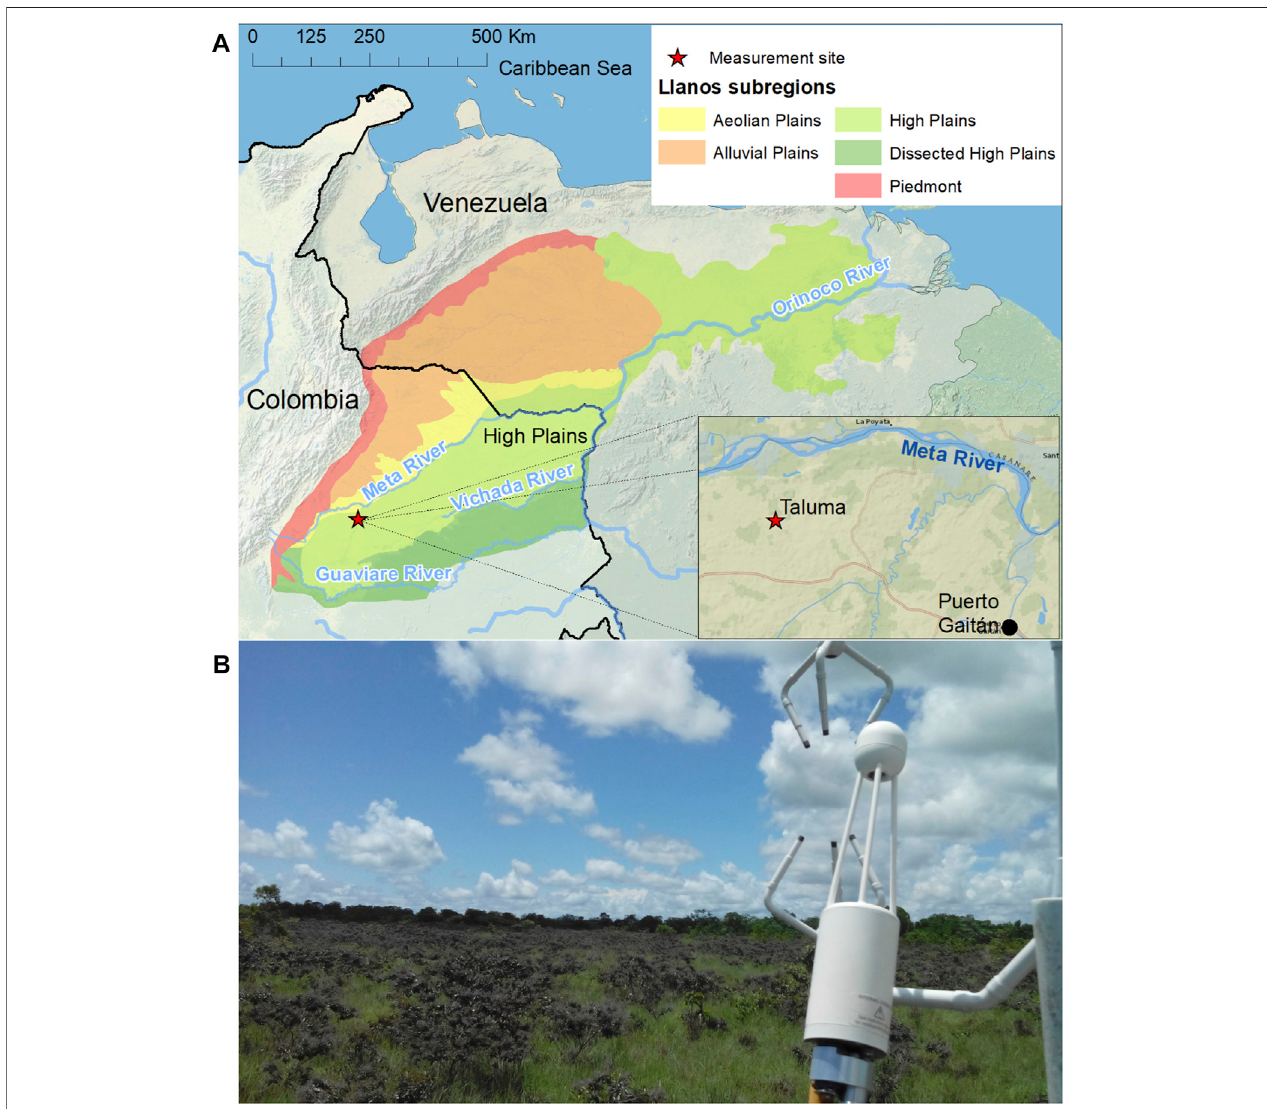
FIGURE 1 | Measurement site. (A) General location of the Colombian Orinoco River basin (Llanos), and its geomorphological subregions. (B) Close-up view of the eddy covariance instrument and its main footprint.